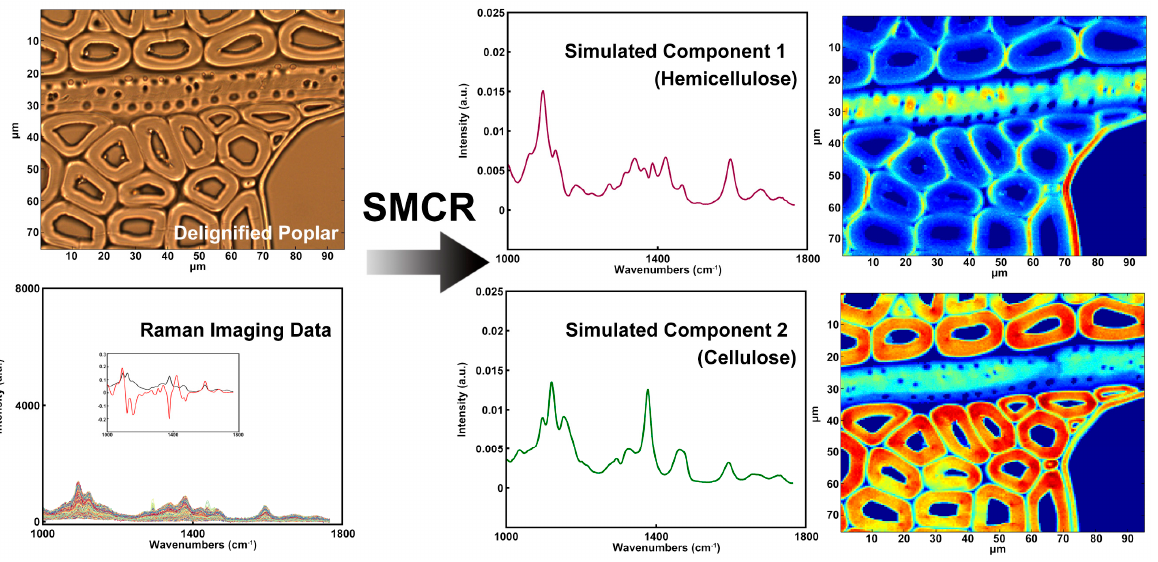
Figure 7. Raman spectra and corresponding distribution images: simulated component 1 (hemicellu- lose); simulated component 2 (cellulose).